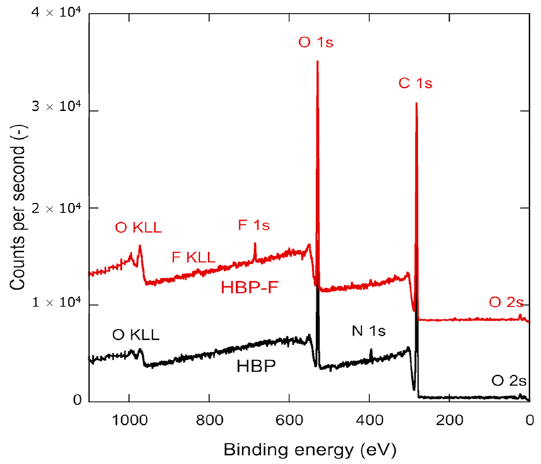
Figure 4. XPS analyses of non-fluorinated HBP (HBP, black spectrum) and fluorinated HBP (HBP + 1.2 wt. % of PFUA and 30 min of air exposure, HBP-F, red spectrum) surfaces.